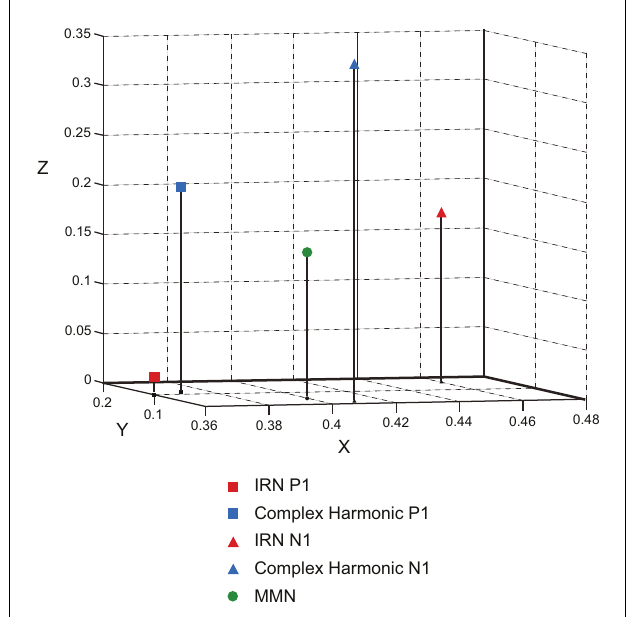
FIGURE 7 |Three-dimensional scatterplot showing the Cartesian coordinates of the P1 and N1 components elicited by the IRN and complex harmonic stimuli, as well as the common MMN elicited by both stimulus types. In the BESA Cartesian coordinate system, the X -axis passes through the Left Pre-Auricular point (LPA) and Right Pre-Auricular point (RPA) with right being the positive direction.The Y -axis passes through the nasion, with rostral being positive.The Z -axis is orthogonal to the X - and Y -axes, with dorsal being the positive direction. Components shown are all located in the right hemisphere, while symmetric sources in the left hemisphere have been omitted for